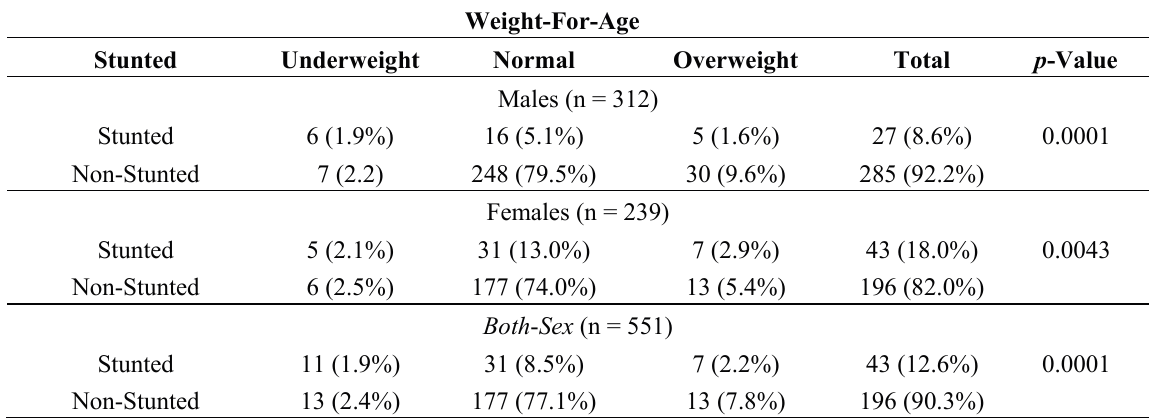
Table 3. Association of stunted growth with nutritional categories by weight for age of adolescents of both sexes. Weight-For-Age Stunted Underweight Normal Overweight Total p -Value Males (n = 312) Stunted 6 (1.9%) 16 (5.1%) 5 (1.6%) 27 (8.6%) 0.0001 7 (2.2) 248 (79.5%) 285 (92.2%)